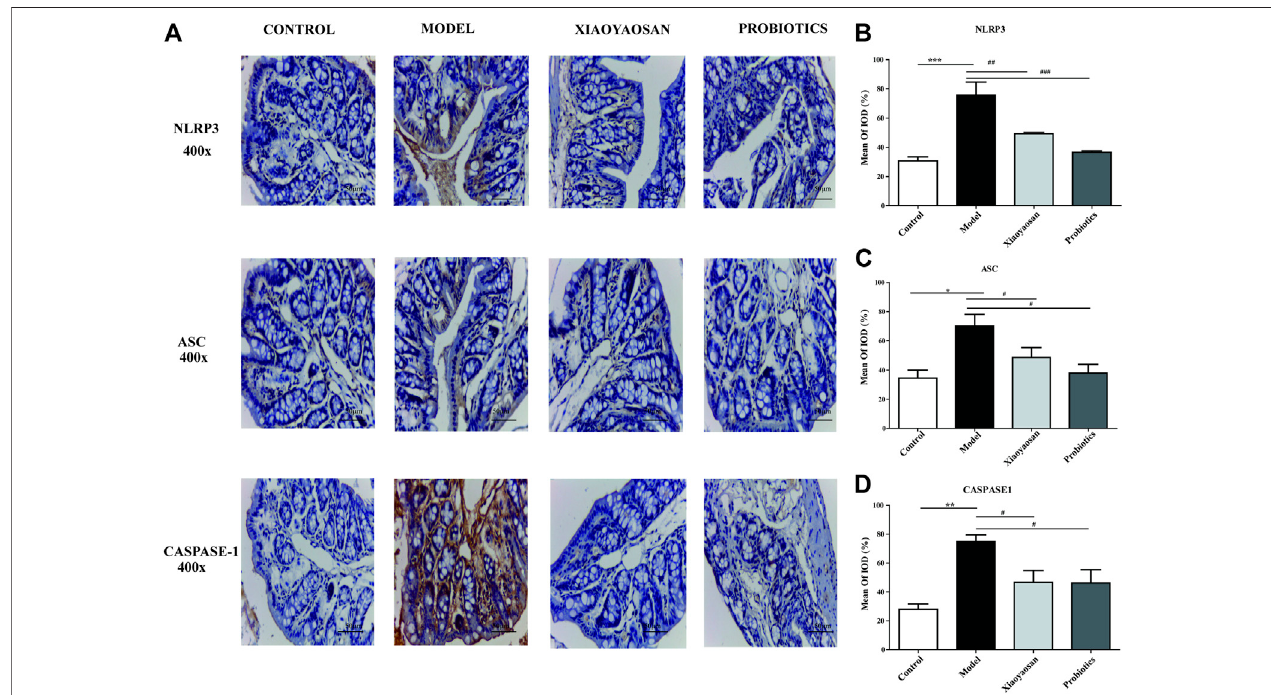
FIGURE 6 | Effects of Xiaoyaosan on the NLRP3-ASC-CASPASE-1 immunolabeling in the colon. (A) Immunohistochemical staining of NLRP3, ASC and CASPASE-1proteinincolon(scalebar (cid:2) 50 mm, × 400magni fi cation). (B) Expression.ofNLRP3incolon. (C) ExpressionofASCincolon. (D) ExpressionofCASPASE-1 in colon. n (cid:2) 6 per group. Data are expressed as the mean ± SEM. * p < 0.05, ** p < 0.01 vs. the control group; # p < 0.05, ## p < 0.01 vs. the antibiotic-induced model